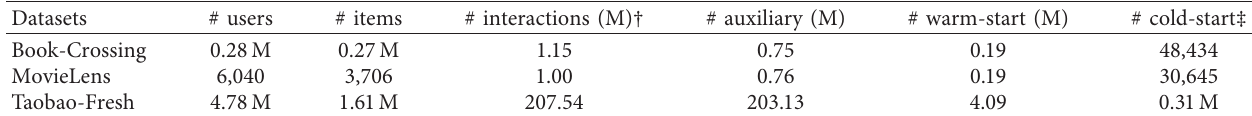
Table 2: The statistics of the datasets.